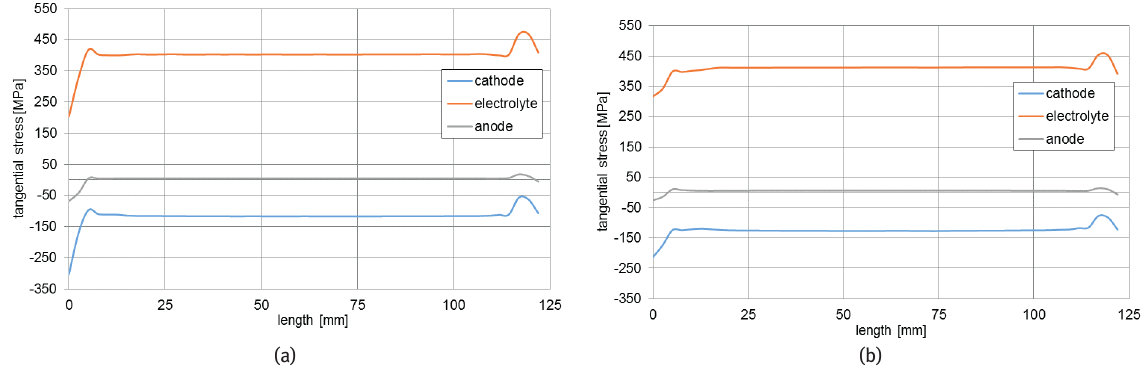
Figure 15: Distribution of operating tangential stress of the mSOFC stack with supporting structure along the horizontal centerlines of each layer: (a) cross-section I, (b) cross-section II.